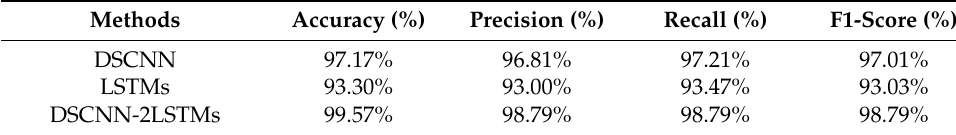
Table 5. Ablation Experiments for Binary Classification Task Recognition.